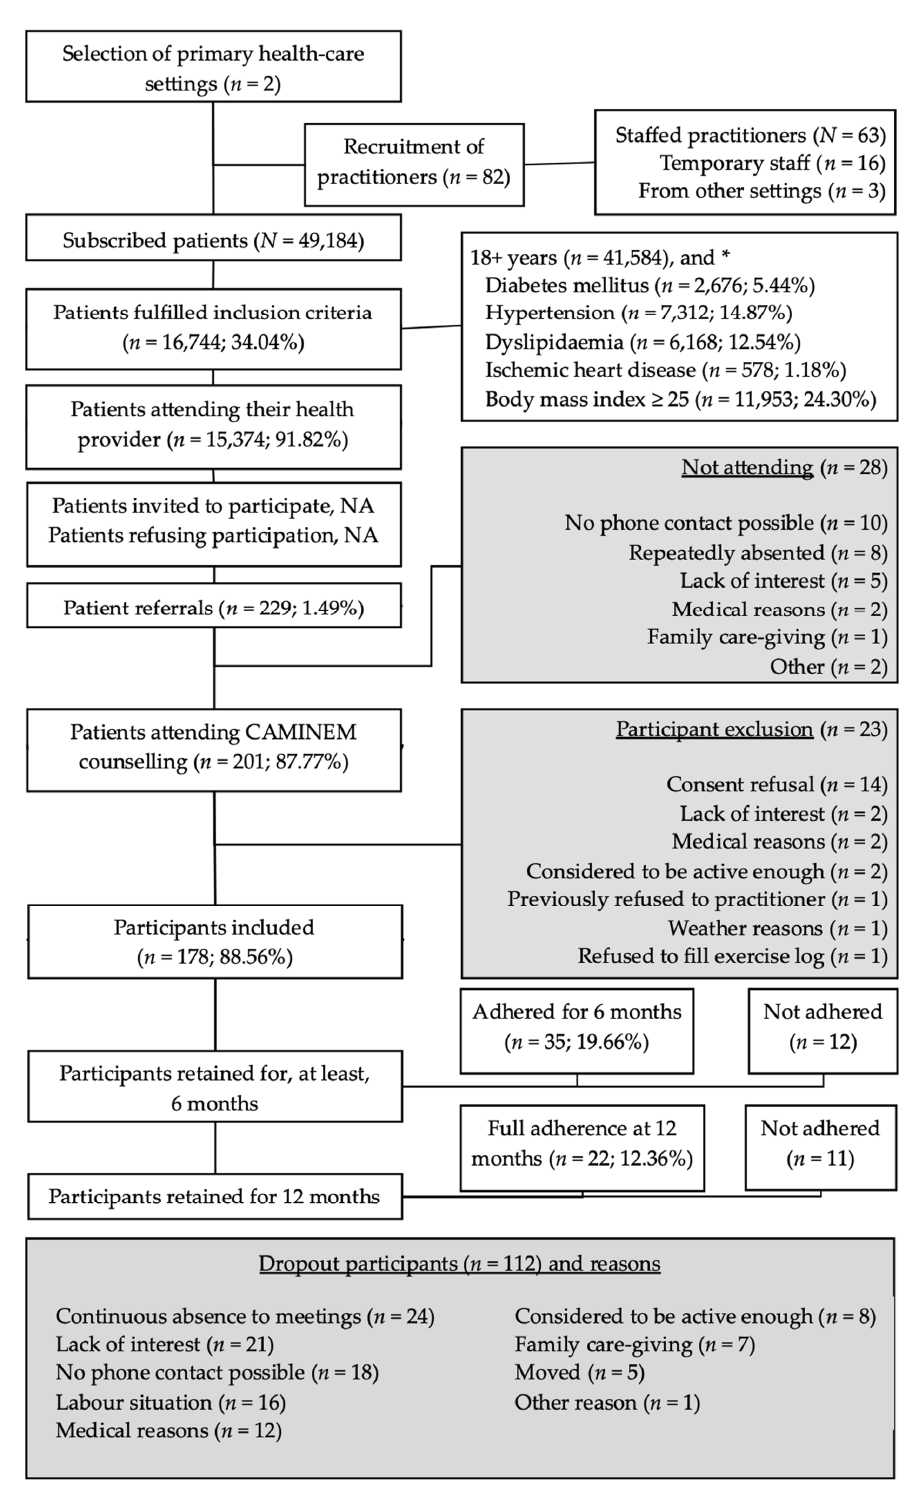
Figure 1. Flowchart of the participants included in the CAMINEM intervention. * Patients may have more than one condition. The CAMINEM Programme addressed patients from two primary health-care settings in socially disadvantaged neighbourhoods. All practitioners (physicians and community nurses) were invited to participate. Patients to be included had to be visited by their practitioner during a regular visit, accepted their oral invitation, being referred to the exercise physiologist and finally sign the informed consent. Retention refers to not drop out while adherence shows fulfillment of the exercise